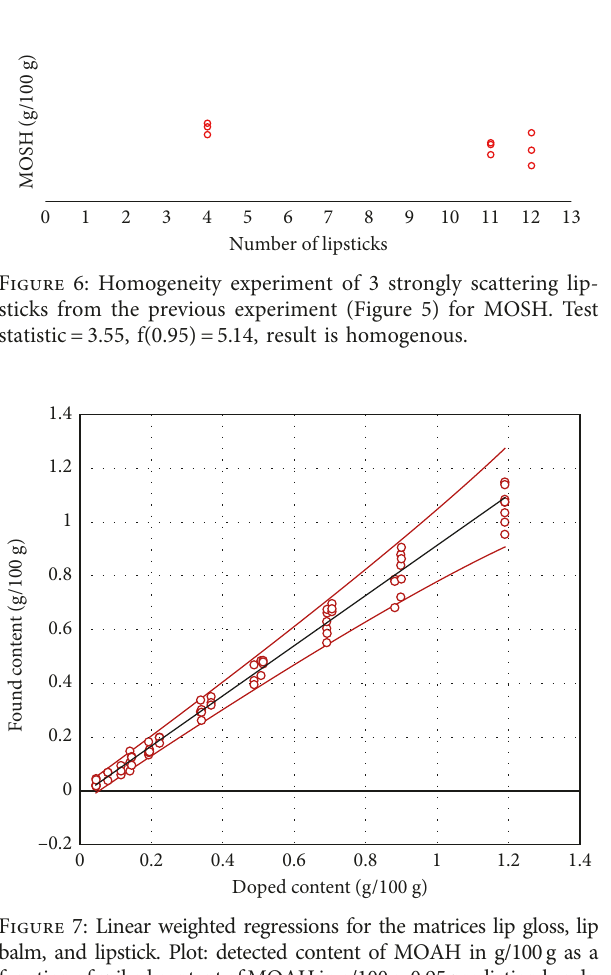
Figure 5: Homogeneity experiment of 36 samples from 12 lipsticks. MOSH (a) test statistic significant inhomogeneous; MOAH (b) test statistic